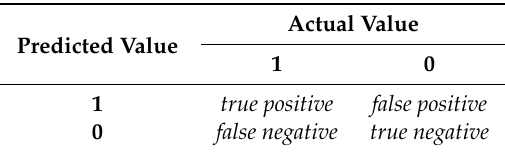
Table 1. Evaluation of classification